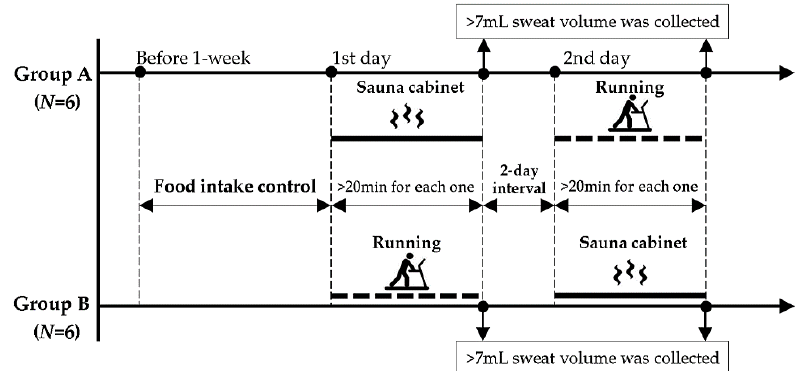
Figure 1. Schematic timeline of study design.